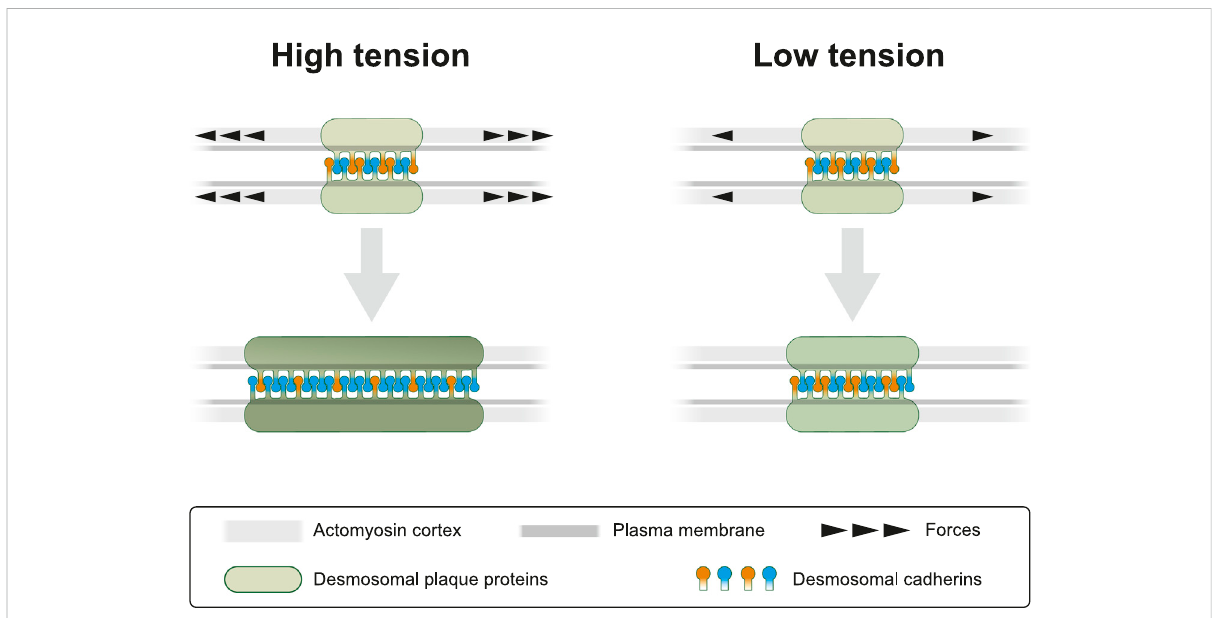
FIGURE 9 Cortical actomyosin tension regulates desmosomal morphogenesis affecting desmosome size and composition. In the present study we modulate cortical actomyosin-dependent tension by pharmacological interference. At high lateral tension desmosomal growth is supported by recruitment of desmosomal plaque proteins (green) and transmembrane proteins (orange and blue). Reduced tension negatively regulates desmosomal growth by selectively decreasing recruitment of desmosomal components. This results not only in smaller desmosomal size but also in different desmosomal composition, which is depicted as a brighter green color of the desmosomal plaque and an altered balance of desmosomal cadherins. The latter is re fl ected by a relative increase of “ orange ” cadherins (e.g., Dsc2) at low tension versus an increased number of “ blue ” cadherins (e.g., Dsg2) at high tension. We take these observations as an indication of the capacity of desmosomes to sense and respond to mechanical